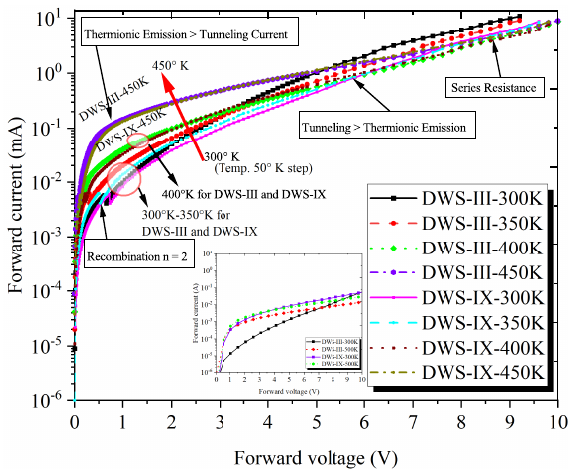
Figure 3. Forward I-V-T characteristic of diffusion welded p -type 4H-SiC-SBD (DWS# III and